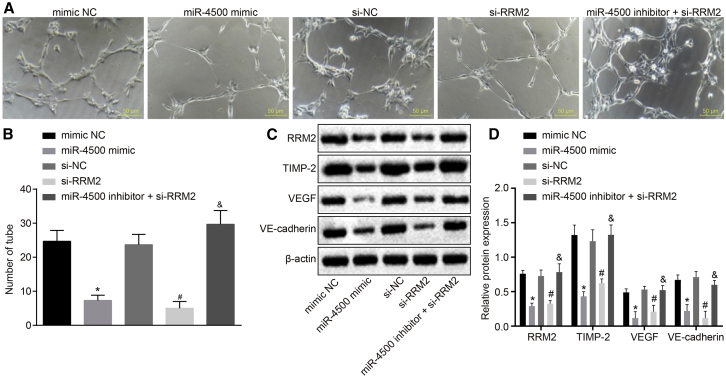
Overexpression of miR-4500 Downregulates RRM2 to Inhibit the Capillary-Like Tube Formation of Endothelial Cells and the Angiogenesis of Breast Cancer Cells(A) Capillary-like tube formation observed under a microscope by in vitro Matrigel-based tube formation assay (200 ×). (B) Comparison of the number of tube in each group. (C) The protein expressions of tumor angiogenic factors TIMP-2, VEGF and VE-cadherin detected by Western blot. (D) Comparison of relative protein expressions of tumor angiogenic factors TIMP-2, VEGF and VE-cadherin in each group. ∗, #, and &p < 0.05 versus the mimic NC group, si-NC group, and si-RRM2 group, respectively. The data comparisons were analyzed by one-way ANOVA, and the experiment was repeated three times independently.